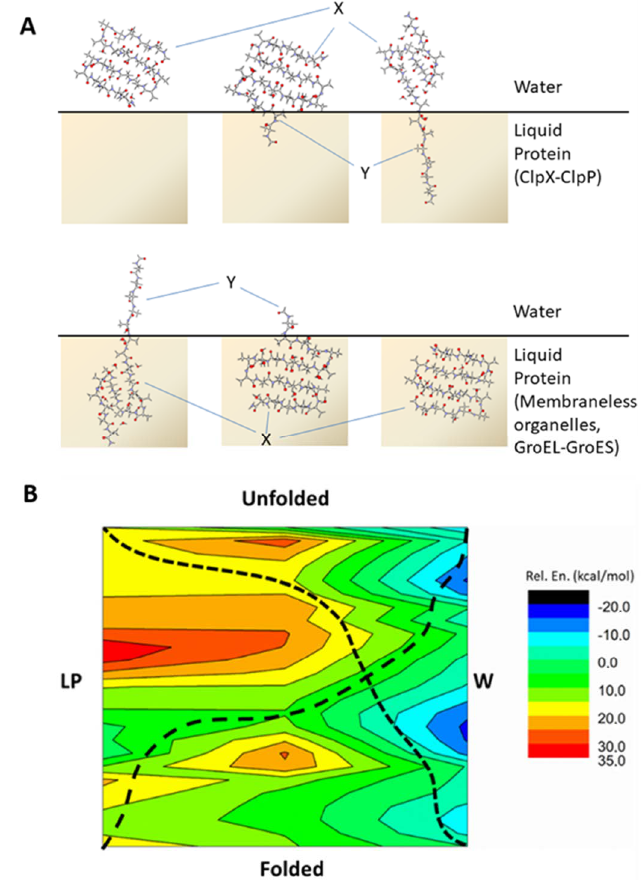
Figure 4. ( A ) Schematic description of protein motif unfolding coupled to changing bulk environment. In order to obtain the relative energy of each motif, E(X-Y), a splitting strategy was employed together with isodesmic reactions according to Equation (S3) (for details see Methods in Supplementary Material). At various stages of the unfolding process the model was split into two parts surrounded by water (X) and a bulk protein environment (Y), respectively (TOP). The same procedure can be applied to a process where the structural change is met by a reverse change of bulk environment (BOTTOM). For more details, see Materials and Methods. ( B ) Schematic relative energy surface coupling folded and unfolded states of 3Turn with phase transition. The surface is based on the investigated 3Turn models and isodesmic reactions as detailed in text. The potentially optimal reaction coordinates are displayed by dashed lines for both the Folded ↔ Unfolded (W ↔ LP) and Folded ↔ Unfolded (LP ↔ W) scenarios.